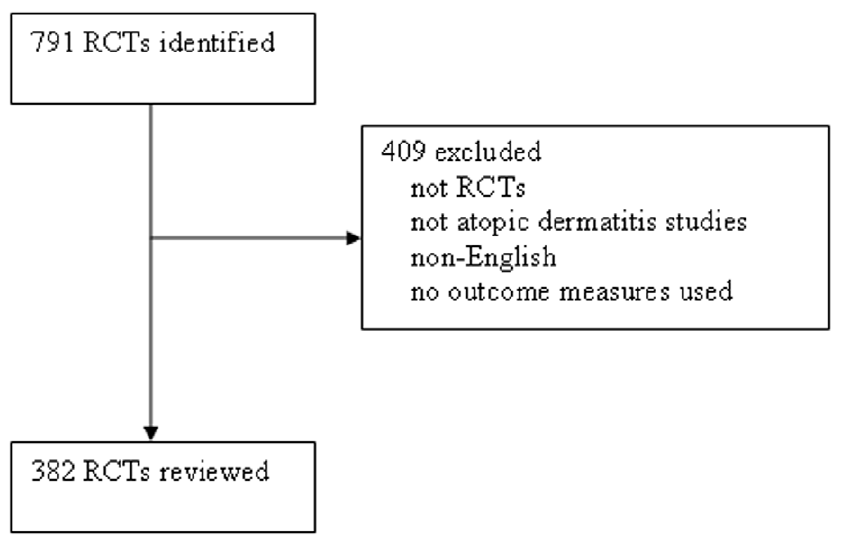
Figure 1. Excluded studies. doi:10.1371/journal.pone.0017520.g001 disease-severity instruments and QoL measures in Tables 1 and 2, respectively.